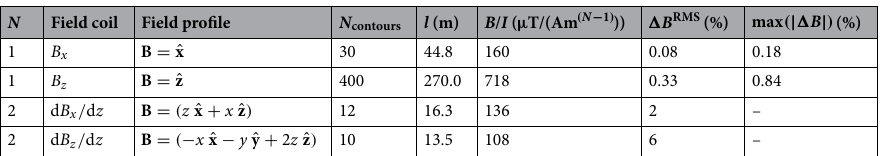
Table 1. Properties of the field coils when the coil system is shielded. Six independent coils generate three order N = 1 uniform fields ( B x , B y , B z ) and three order N = 2 constant linear field gradients ( d B x / d z , d B y / d z , d B z / d z ). The B x and d B x / d z coils have identical properties to the B y and d B y / d z coils, respectively. For each wire configuration of length l , the streamfunction is contoured with N contours to generate a magnetic field profile B with a field strength per unit current B / I averaged along the z -axis of the optimisation region. For each coil, the difference between the normalised field in the standalone shield and the target field, (cid:31) B = B − B des. , as a percentage of the desired field, is evaluated along the z -axis of the optimisation region and its root-mean-square (RMS) value is calculated. For the B x and B z coils, the maximum deviation from perfect field uniformity, max ( | � B | ) , is also evaluated in the same region. All magnetic field values are calculated from experimentally measured